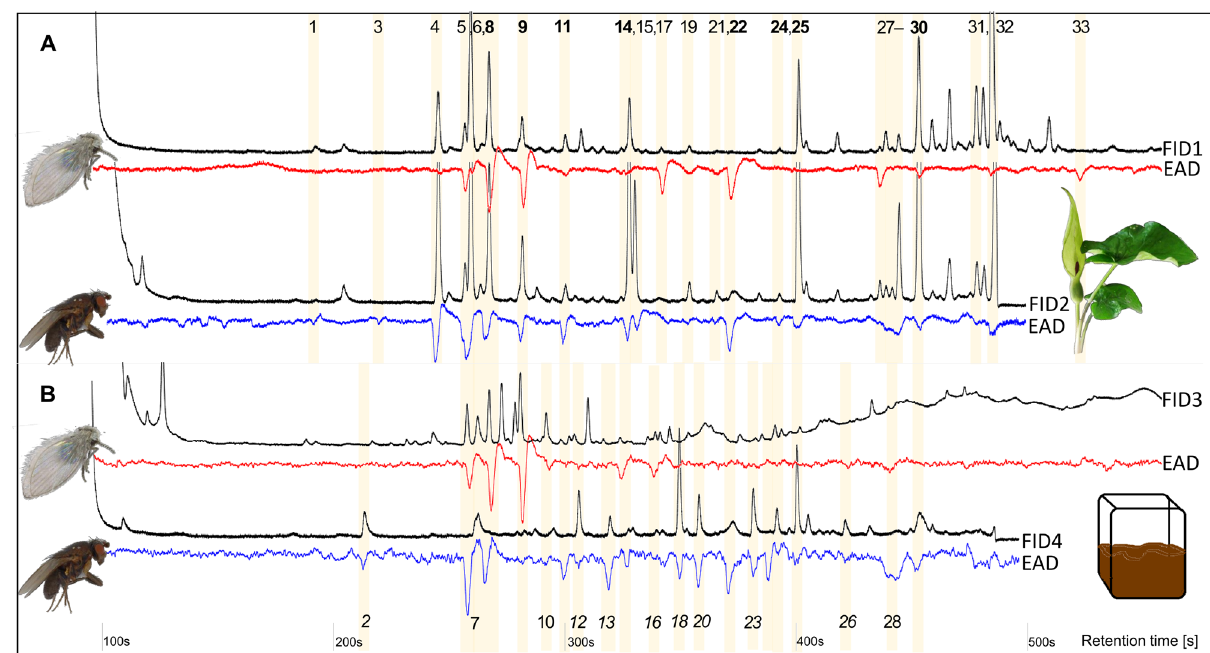
Figure 2. Representative physiological responses (gas chromatography coupled to electroantennographic detection) of a female Psychoda sp . (Psychodidae; red) and a female Coproica ferruginata (Sphaeroceridae; violet) to scent samples of ( A ) inflorescences of Arum maculatum and ( B ) cow dung (fresh and 1-day old). EAD-active compounds (see also Table 1): (1) UNK883; (2) hexanal; (3) 1-hexanol; (4) 3,7-dimethyloct-1-ene; (5) ( +)- α -citronellene; (6) ( +)- β -citronellene; (7) 3,7-dimethyl-2-octene isomer 1; (8) 3,7-dimethyl-2-octene isomer 2; (9) 2,6-dimethyl-2,6-octadiene isomer 2; (10) 6-methyl-5-hepten-2-one; (11) UNK1030; (12) octanal; (13) p -cymene; (14) 6-methyl-5-heptene-2-ol; (15) 1-octen-3-ol; (16) 2-methylbutanoic acid; (17) 2-nonanone; (18) nonanal; (19) 2,6-dimethyl-7-octen-2-ol; (20) ( E )-2-octen-1-ol; (21) ( S )-linalool; (22) 2-decanone; (23) UNK1135; (24) decanal; (25) p -cresol; (26) 3,7-dimethyl-1-octanol; (27) α -copaene; (28) UNK1378/81; (29) UNK1394; (30) UNK1415; (31) indole; (32) UNK1503/UNK1492; (33) UNK 1658. Numbers in bold (top